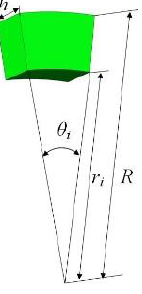
Figure 4. A tessellation unit.